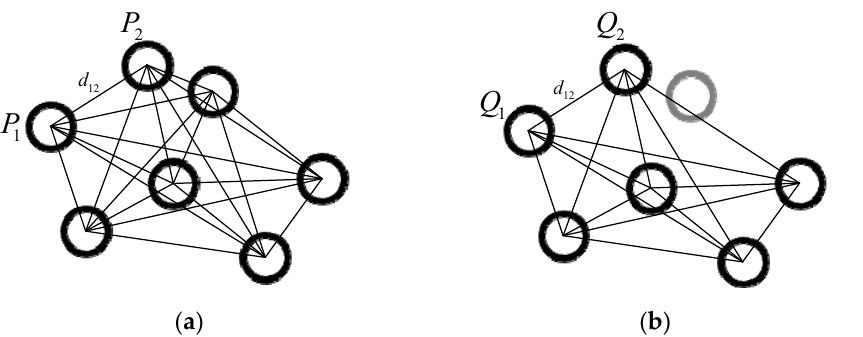
Figure 5. ( a ) Schematic diagram of the reference distance library. ( b ) Schematic diagram of the sample distance library.